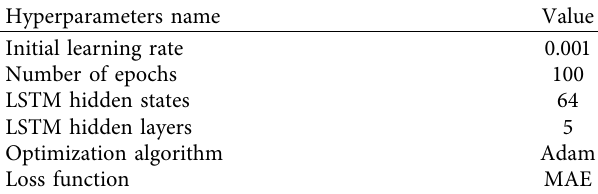
Table 3: Summary of notations in Section 3. Table 4: Training